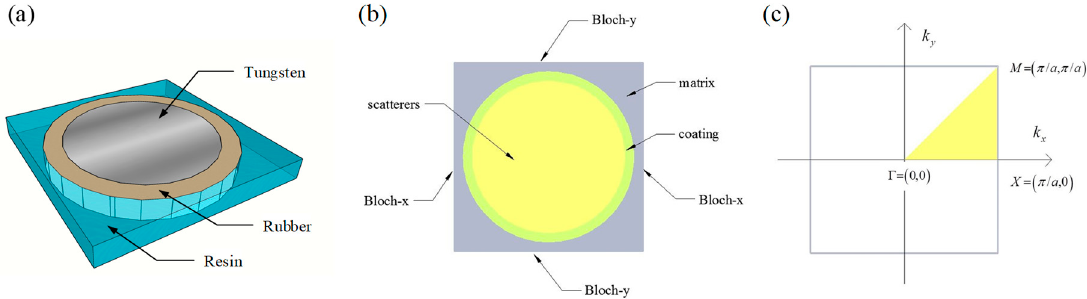
Figure 1. Cells and irreducible Brillouin zone: ( a ) is the 3D model of the single-layer phononic crystal plate cell and ( b ) is the top view of the cell. The yellow triangle in ( c ) is the irreducible Brillouin zone.